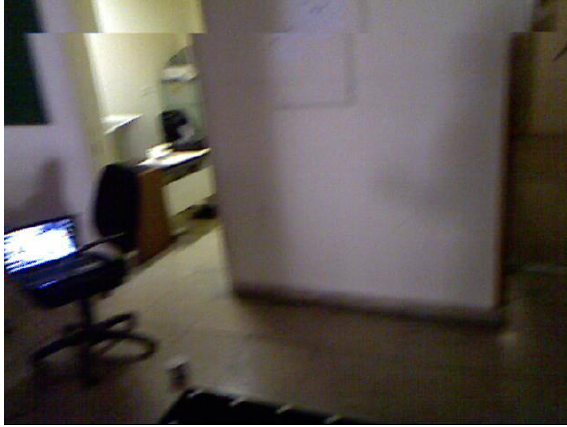
Figure 6. Break-line in image, due to transfer error.